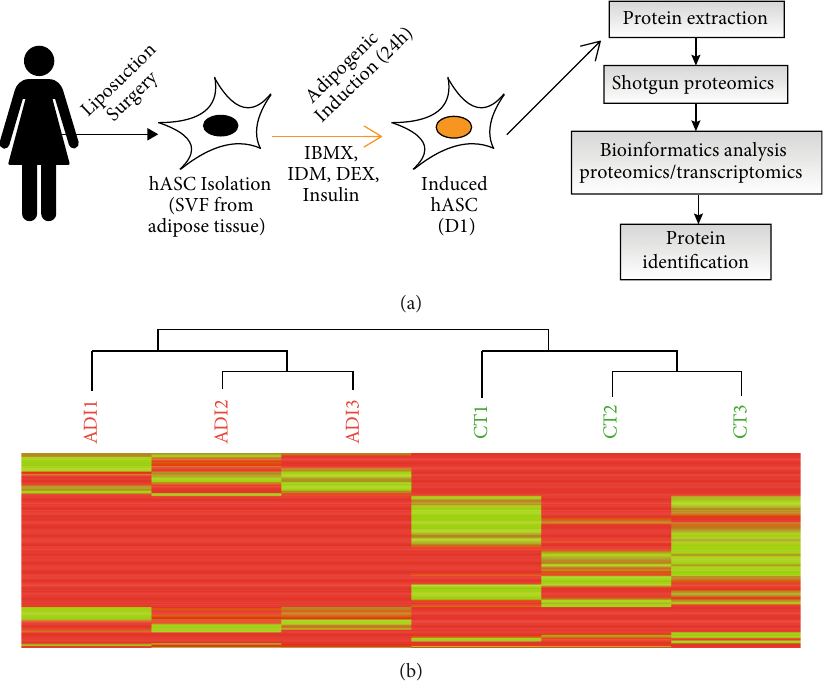
Figure 1: Triggering adipogenesis in hASC. (a) Schematic illustration of adipose tissue collection following by hASC isolation and in vitro adipogenic di ff erentiation process with standard cocktail. (b) The clustergram was generated by applying hierarchical clustering to the ADI and CT proteomic pro fi les. The red and green indicate ADI and CT samples, respectively. Each line encodes the NIAF quantitation for a peptide; the encoding ranges from red for low-intensity NIAF quantitation to green for high-intensity NIAF